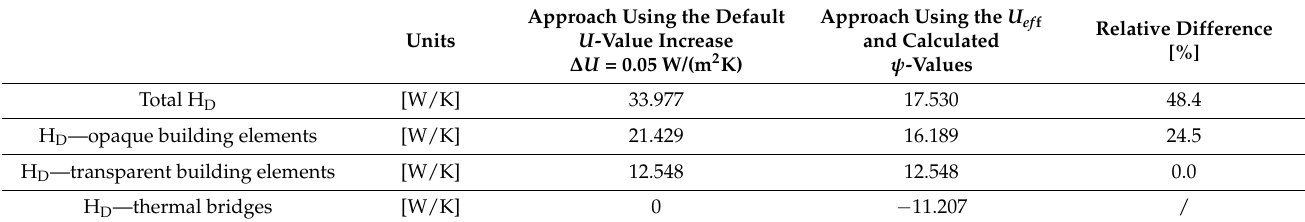
Table 7. Transmission heat losses H D for the case of the MUZA.